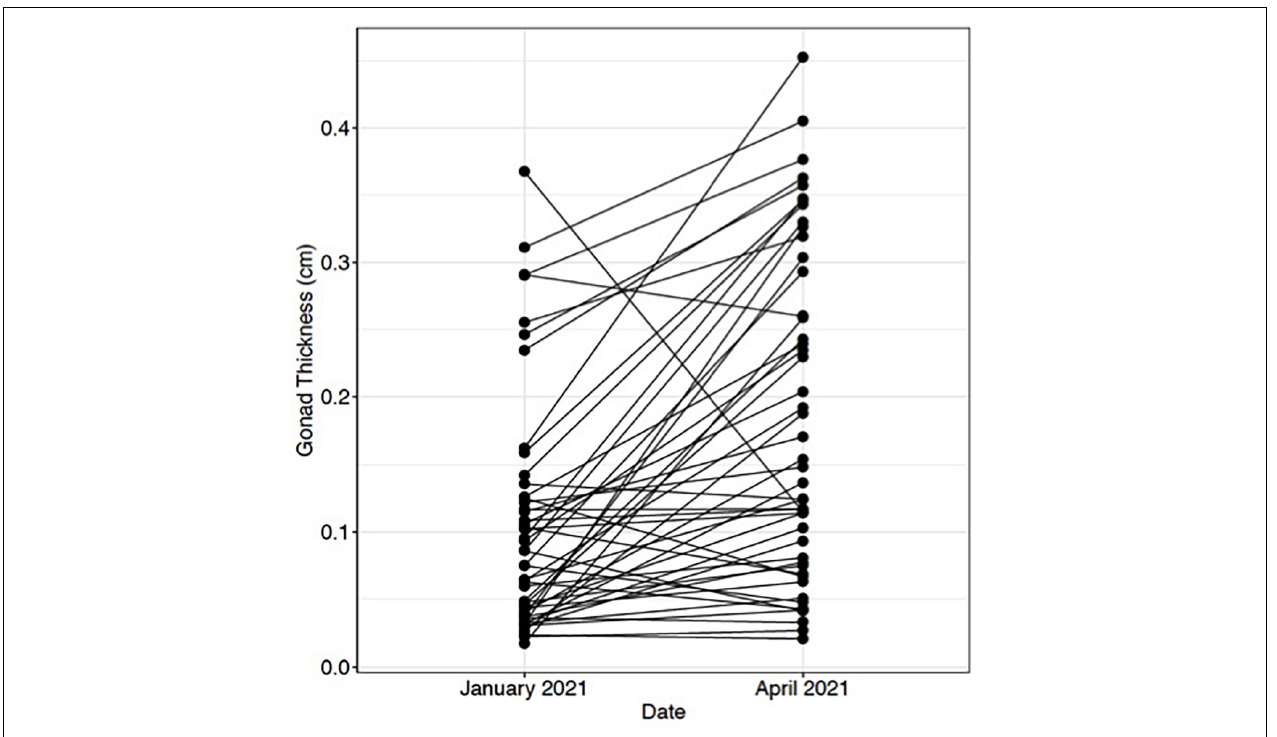
FIGURE 5 | Change in red abalone ( Haliotis rufescens ) gonadal thickness from January 2021 to April 2021. Each point represents an individual abalone and black lines indicate change in gonadal